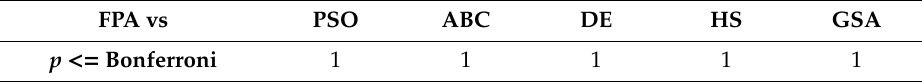
Table 8. Bonferroni correction for the case of FPA comparison.